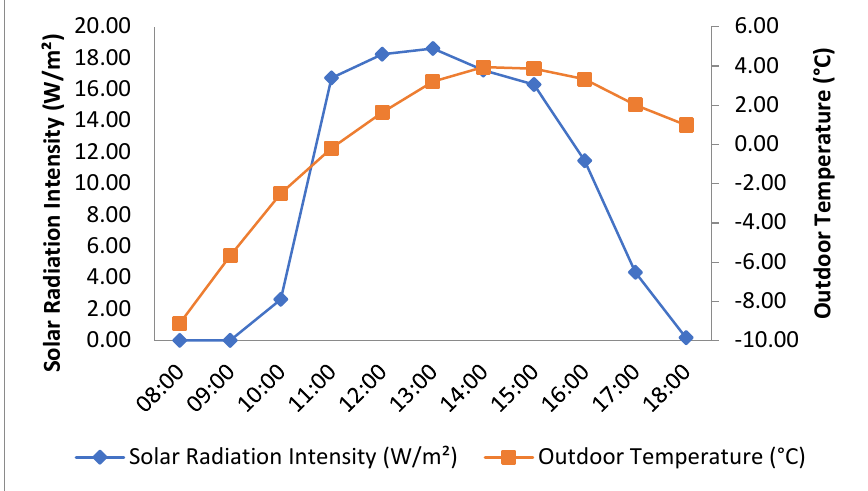
Figure 9 Solar radiation intensity and outdoor temperature for February 12 in